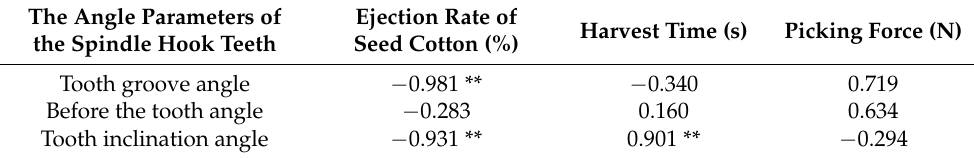
Table 3. Correlation test results of various hook angle parameters.